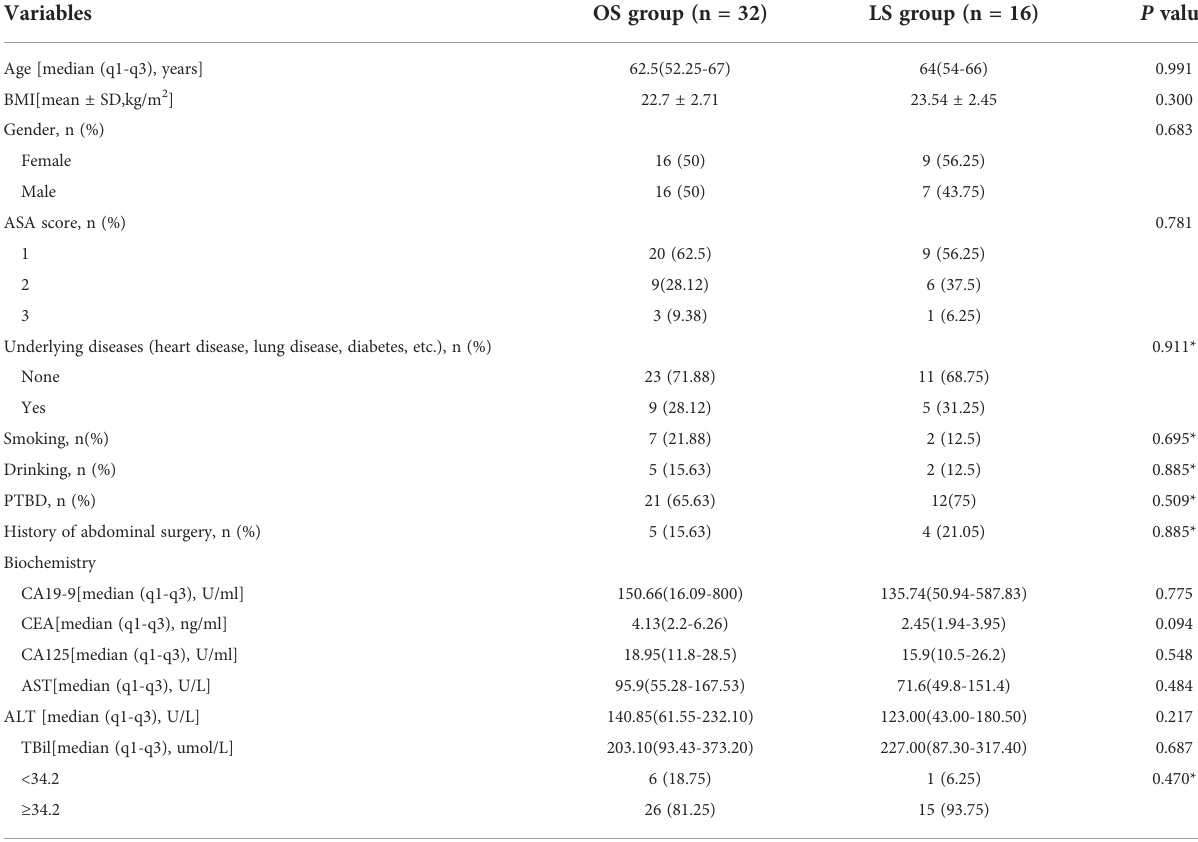
TABLE 1 Demographic and baseline characteristics in the OS and LS